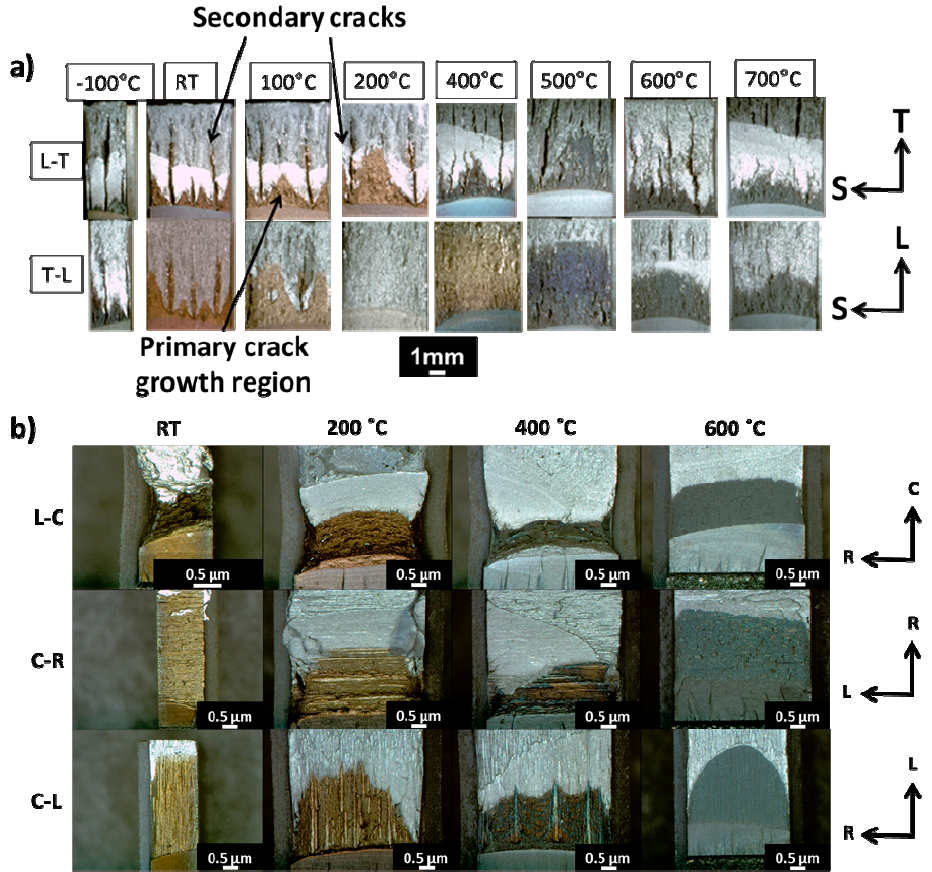
Figure 7. Stereo microscope images of ( a ) ODS-KIT HR and ( b ) ODS-KIT HE fracture surfaces at different temperatures and in different orientations.